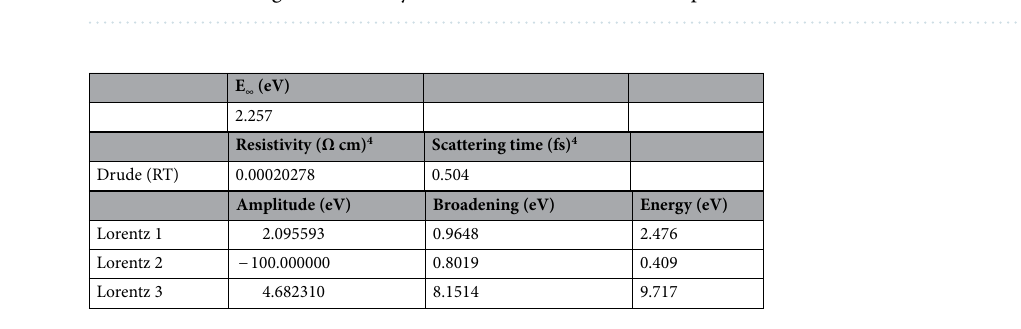
Table 1. Best-fit parameters of TiAlC layer obtained by Gen-Osc